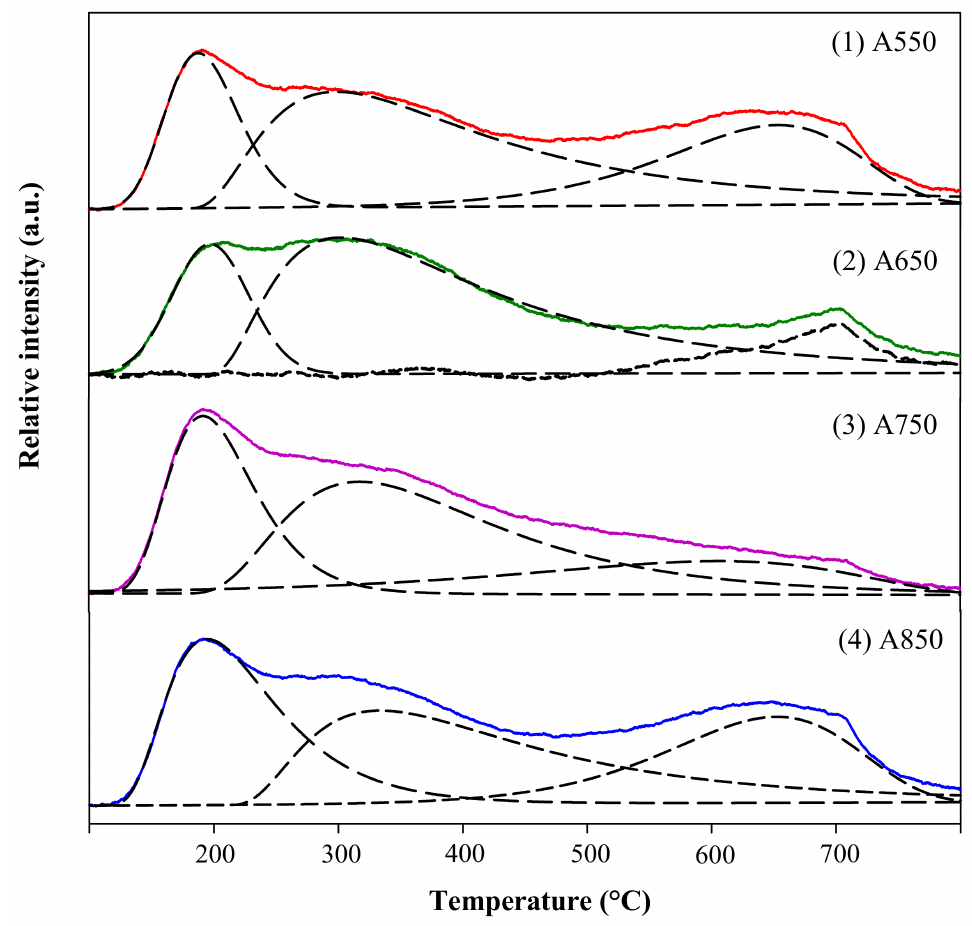
Table 1. The NH 3 -TPD analysis depicting the acidic sites and coke amount in each catalyst. Amount of Acidic Sites (mmol-NH 3 /g-Catalyst) Catalyst Weak Moderate Strong Total (Weak +